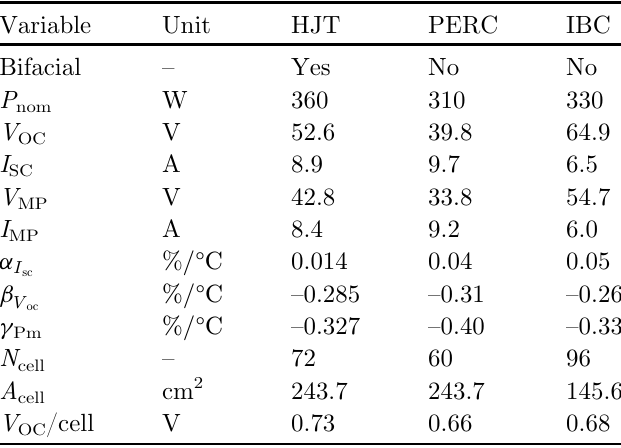
Table 1. Data sheet electrical parameters of photovoltaic modules under investigation.